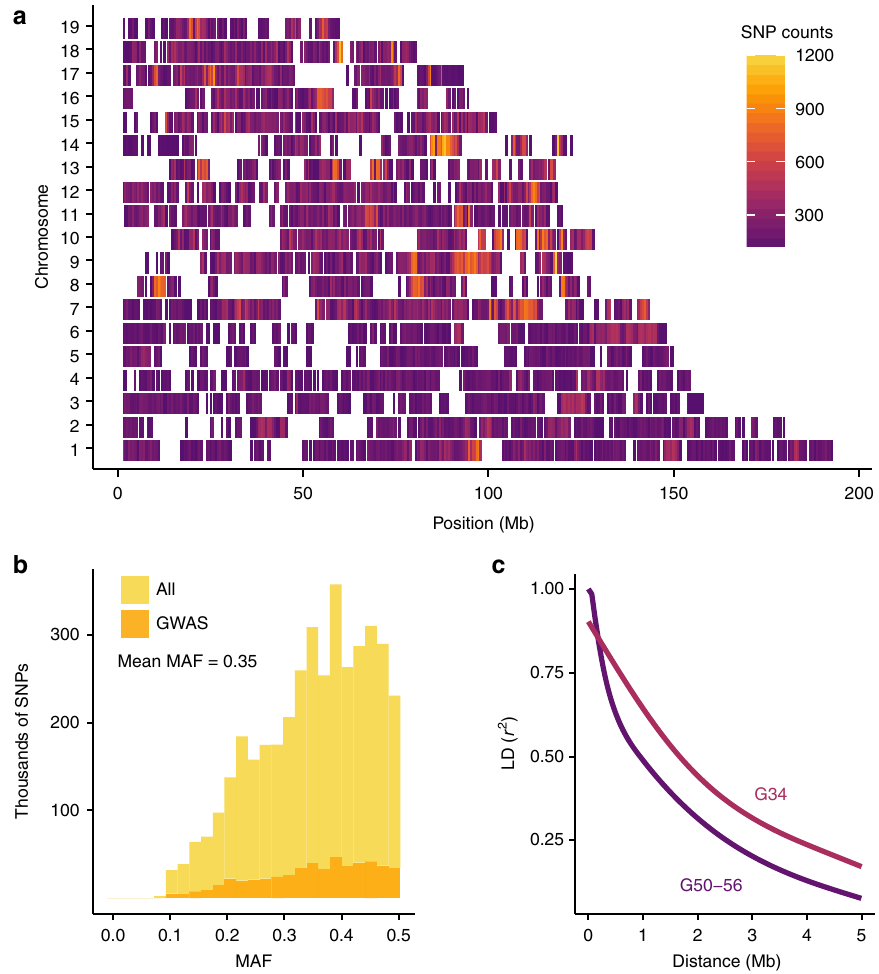
Fig. 1 Variants, MAFs and LD decay in the LG × SM AIL. Imputation provided 4.3 million SNPs. Filtering for LD ( r 2 ≥ 0.95), MAF < 0.1, and HWE ( p ≤ 7.62 × 10 − 6 , Chi-squared test) resulted in 523,028 SNPs for GWAS. a SNP distribution and density of GWAS SNPs are plotted in 500 kb windows for each chromosome. As shown in Supplementary Figure 1, regions with low SNP density correspond to regions predicted to be nearly identical by descent in LG and SM 21 . b MAF distributions are shown for 4.3 million imputed SNPs (gold; un fi ltered) and for the 523,028 SNPs used for GWAS (orange; fi ltered). Mean MAF is the same in both SNP sets. c Comparison of LD decay in G50 – 56 (dark purple) and G34 (light purple) of the LG × SM AIL. Each curve was plotted using the 95th percentile of r 2 values for SNPs spaced up to 5 Mb